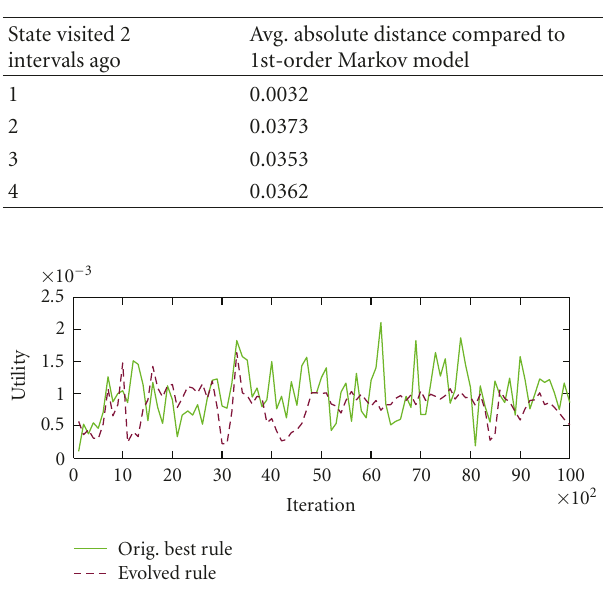
Figure 11: Comparison of utility achieved by the best rule in the original space, and the evolved